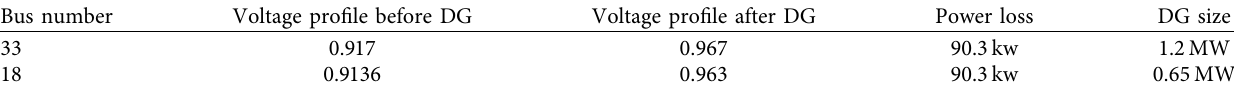
Table 13: DG sizing.